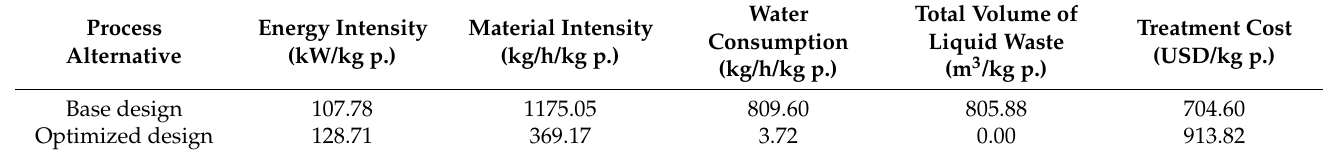
Table 3. Summary of technical indicators for design alternatives.